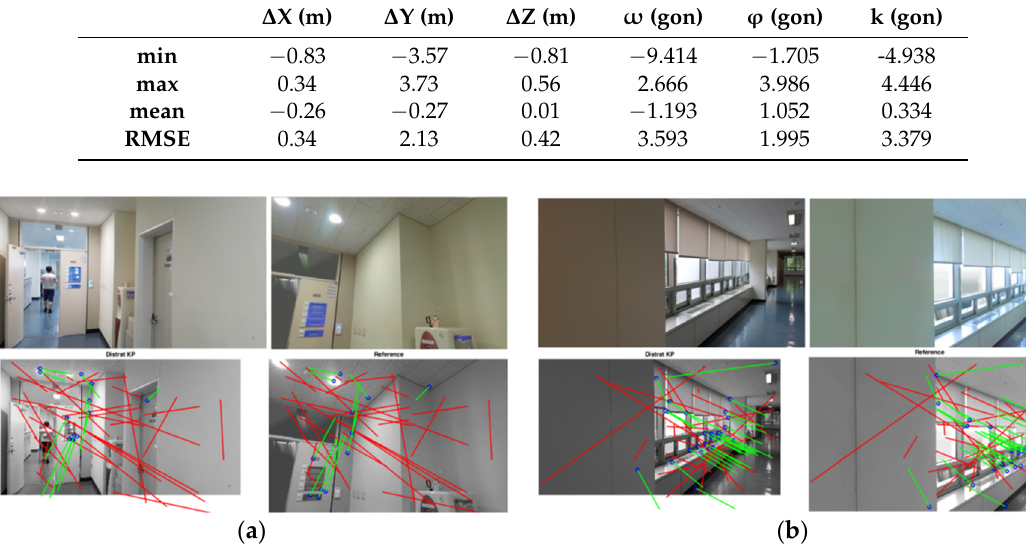
Figure 15. ( a ) Worst solution for the ETRI Building due to the low number of feature points that are rather close; and ( b ) worst solution in Z for the ETRI Building due to image similarity from different floors.